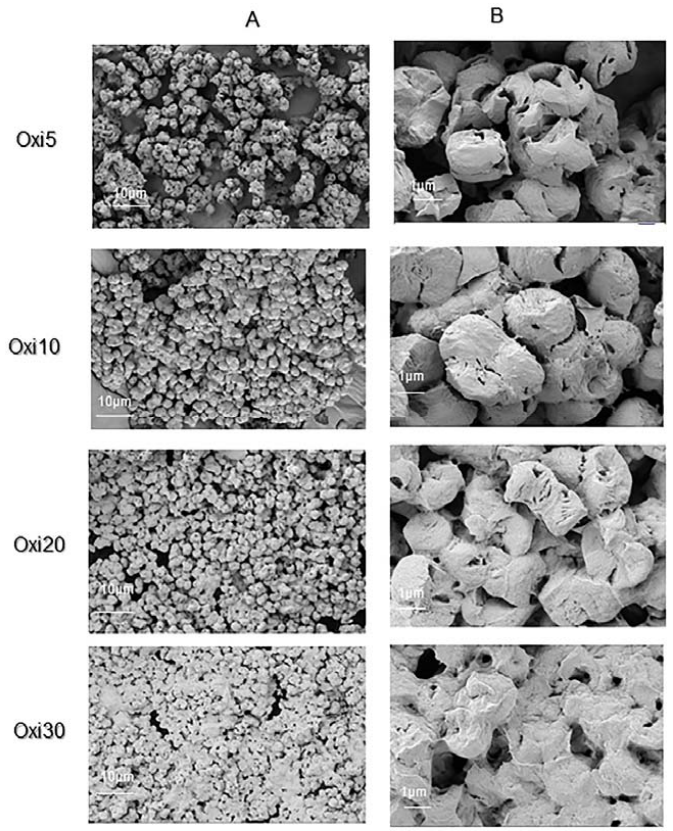
Figure 4. SEM of oxidized inulin samples at two different magnification sizes: 10 μ m ( A ) and 1 μ m ( B ).